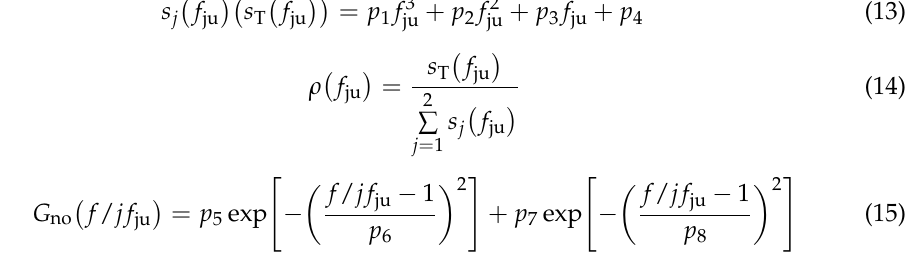
Table 2. Model coefficients for the auto-PSD.